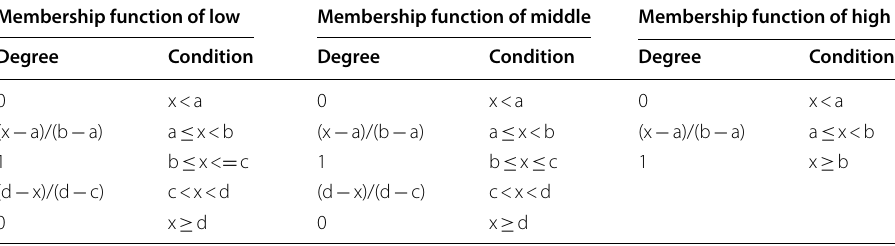
Table 9 Parameter of membership function for percentage of anomaly occurrence Membership function of